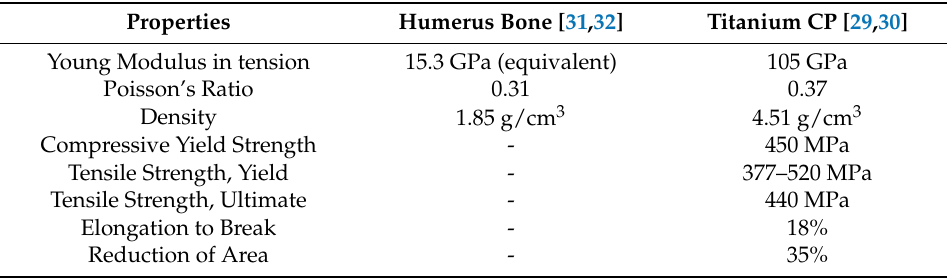
Table 3. Mechanical properties of the materials used in the FEM